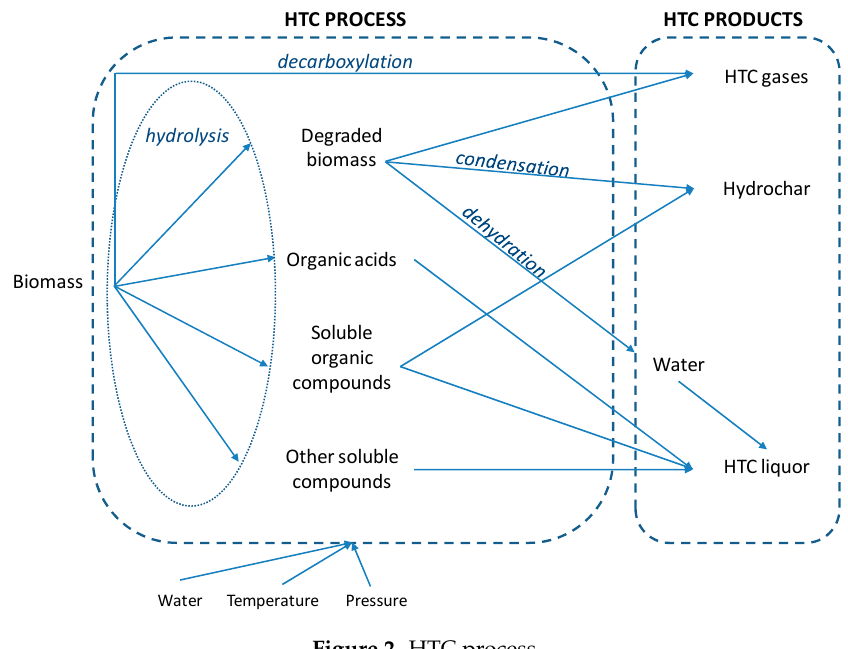
Figure 2. HTC process.